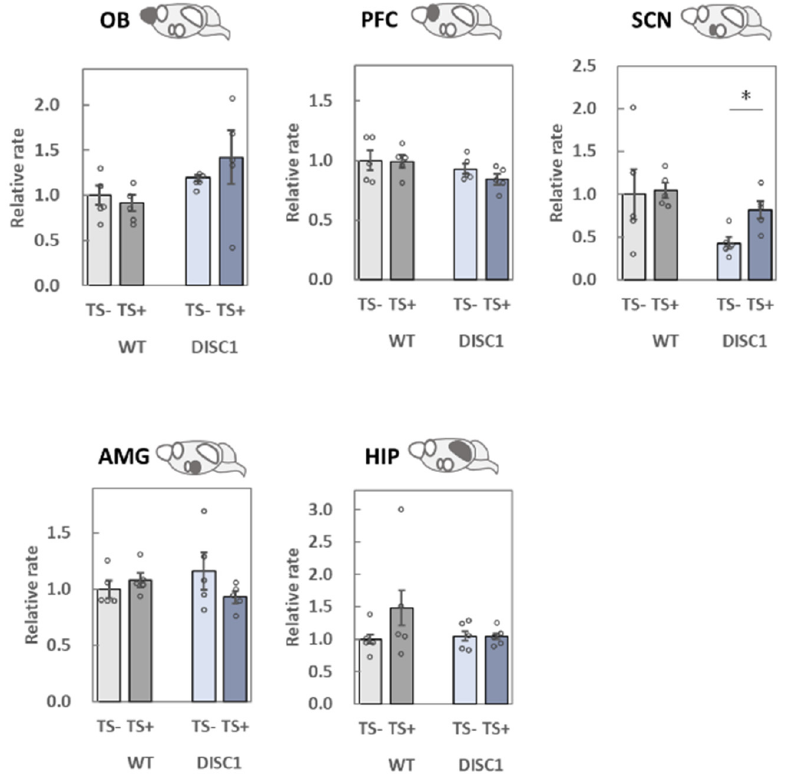
Figure 5. Measurement of NCAM levels using ELISA. NCAM expression levels in the five brain regions collected from the four groups of mice were analyzed. The samples were added to the wells of a 96-well plate (250 ng as protein) and treated with endo-N to determine the NCAM protein levels. NCAM was measured using the anti-CD56 antibody. All data points (each mouse) represent the average of the three assays. The average in group 1 [WT, TS-] was set to 1. Error bars indicate the SEM ( n = 5). OB: olfactory bulb, PFC: prefrontal cortex, SCN: suprachiasmatic nucleus, AMG: amygdala, HIP: hippocampus. *: p < 0.05.